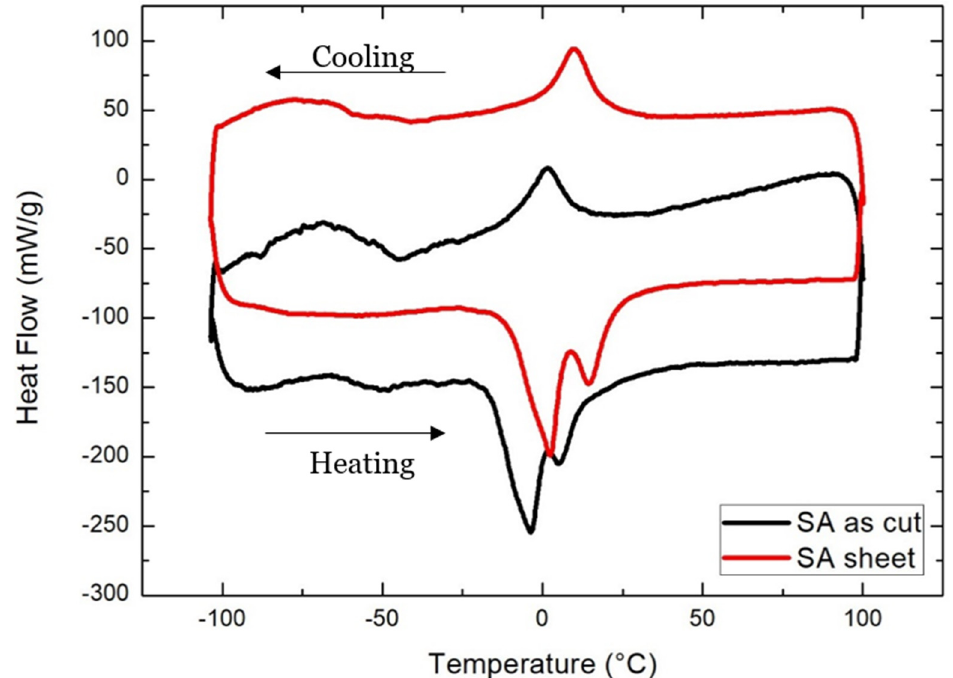
Figure 8. DSC scans of the straight-annealed sheet and the laser-cut diamond-like element. The evolution of the superelasticity of the diamond-like element, laser-cut in SA condition, was studied via the static force/displacement curves, performed at low (30 ◦ C) and high (100 ◦ C) temperatures, and is reported in Figure 9. In good agreement with the DSC characterisation, the element was fully austenitic at 30 ◦ C. In fact, the typical flaglike curve was revealed during the loading/unloading testing. A force of 1.6 N was achieved at the plateau of the force/displacement curve upon loading, and about 0.7 N upon unloading.